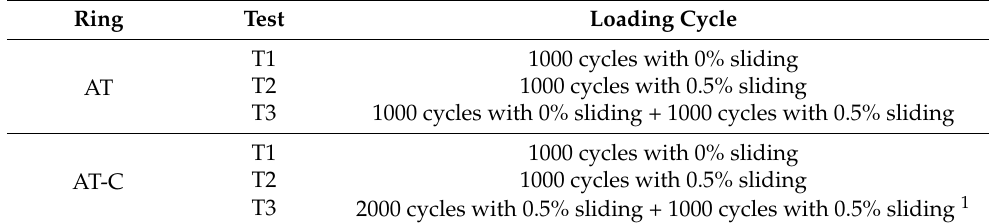
Table 2. Summary of the mechanical loadings for both tested rings (AT and